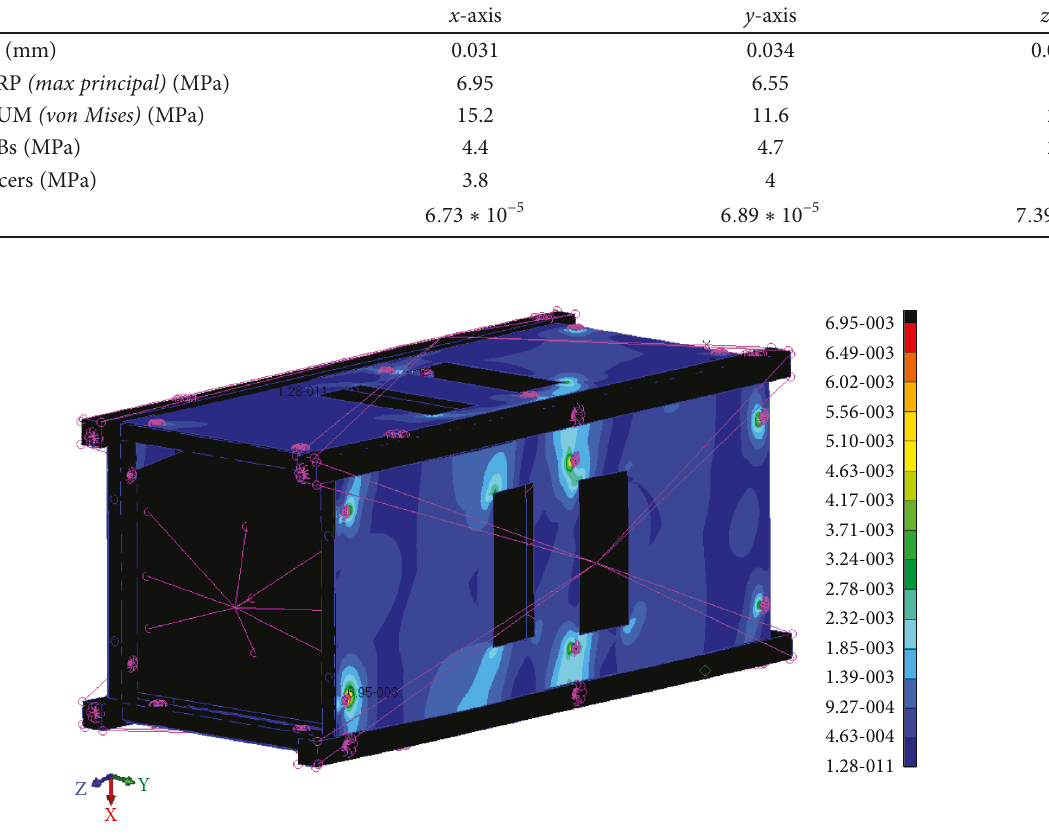
Figure 7: Stress distribution ( x